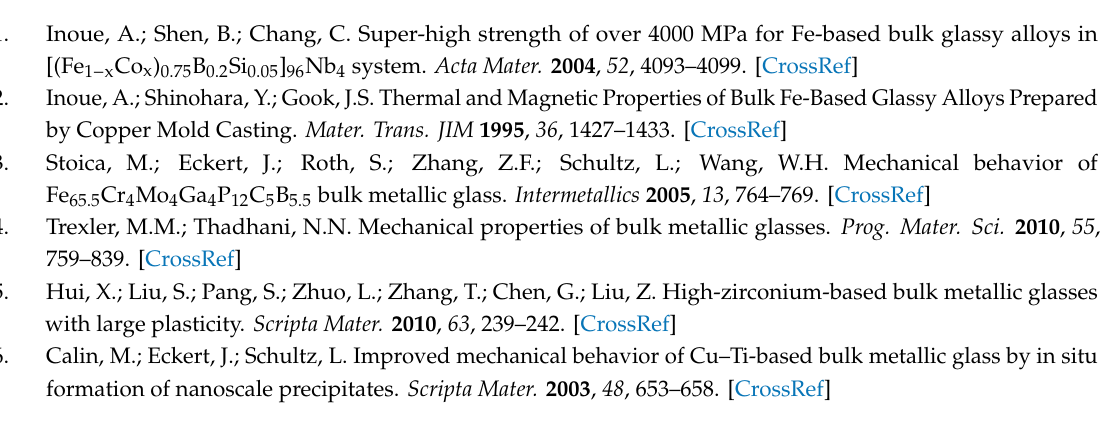
Figure S1: DSC traces (heating rate 20 K / min) of as-cast [FeCoBSiNb] 100 − x (Ga) x (x = 0, 0.5, 1 and 1.5) glassy samples, Figure S2. SEM, EDS and EBSD results obtained on a [FeCoBSiNb] 98.5 Ga 1.5 sample after the compression test; Figure S3. (a), (b), (c) and (d) are the EBSD patterns obtained from the fracture surface for the points 1, 2, 3 and 4, respectively, Table S1. EDS results of all the points in Atomic percent (%). Spectra 1, 2 and 3 were recorded on molten region, spectra 4 and 5 are on fractured zone without